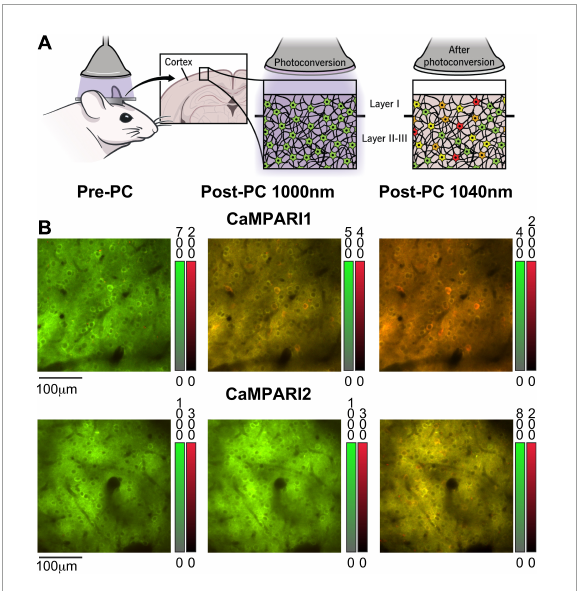
FIGURE1 Calcium-modulated photoactivatable ratiometric integrator can measure neuronal activity using either PC or dynamic recording. (A) Schematic illustration of CaMPARI’s photoconversion process, as used in this study. A mouse was implanted with a cranial window, injected with an AAV to express CaMPARI, and then illuminated with 400 nm light while presented with a visual stimulus to the contralateral eye (left). Before PC, CaMPARI emits green fluorescence, and when illuminated with 400 nm light it gradually changes its color to red in active neurons (middle and right panels). The transition from green to red is irreversible at the single protein level, and the red signal slowly decays within days as the red protein deteriorates (Das et al., 2022). (B) Example images from the mouse V1 in vivo , showing neurons expressing CaMPARI1 and CaMPARI2 (upper and lower rows, respectively) before PC (left column), and after PC when captured with 1,000 nm excitation (middle column) or 1,040 nm excitation (right column). Color bars next to each image show the green and red fluorescence signal